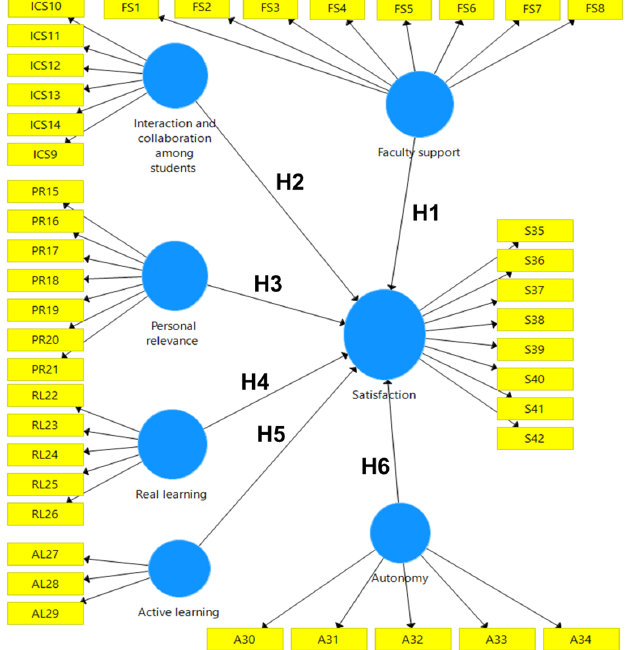
Fig. 3. Conceptual model and research